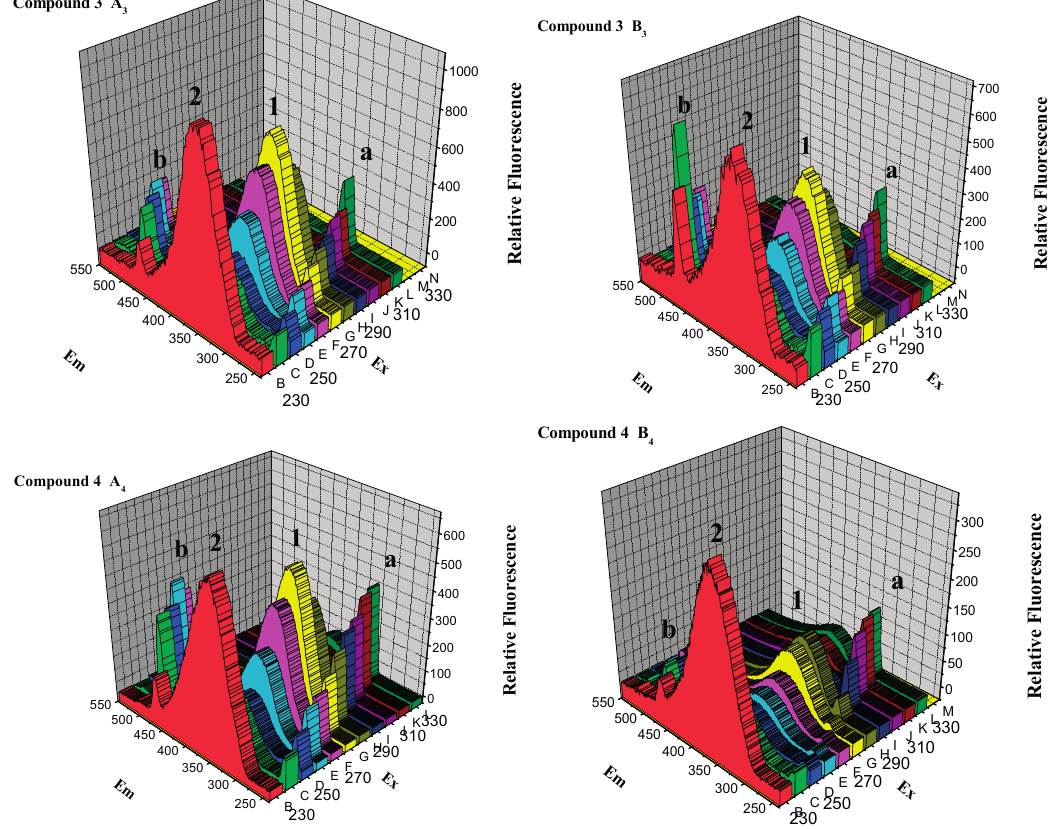
Figure 10. Three-dimensional fl uorescence spectra of BSA in the absence ( A ) and presence ( B ) of compounds 1 – 4 . Conditions: c (BSA) = 1.04 × 10 − 6 mol·L − 1 , c